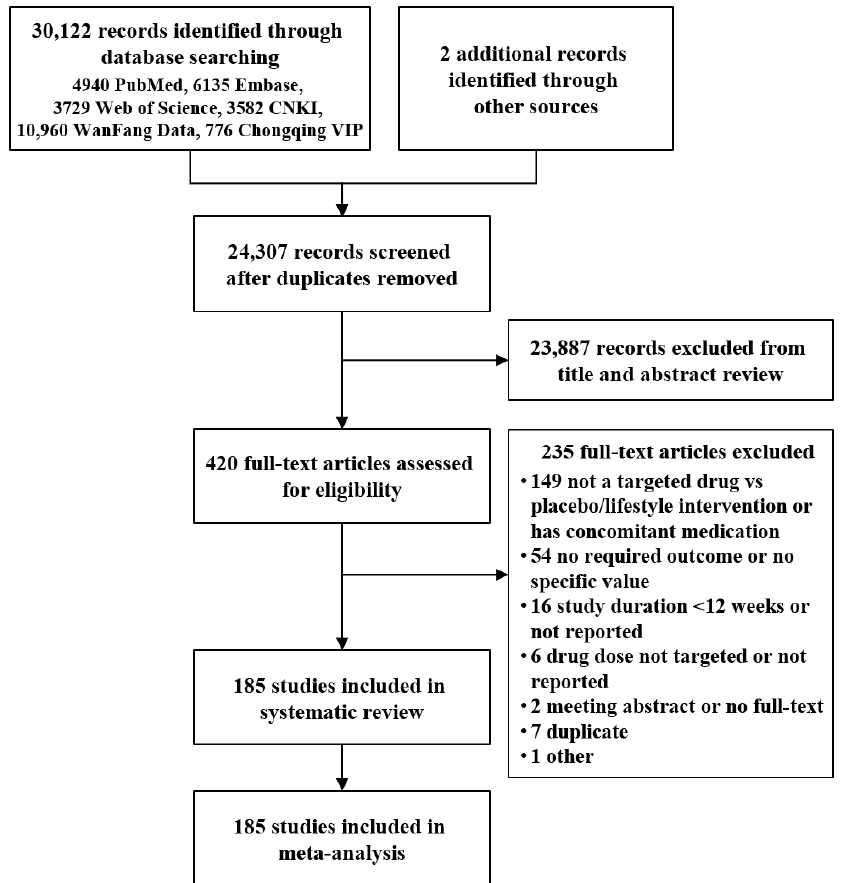
Figure 1. PRISMA flow diagram of study search and selection.